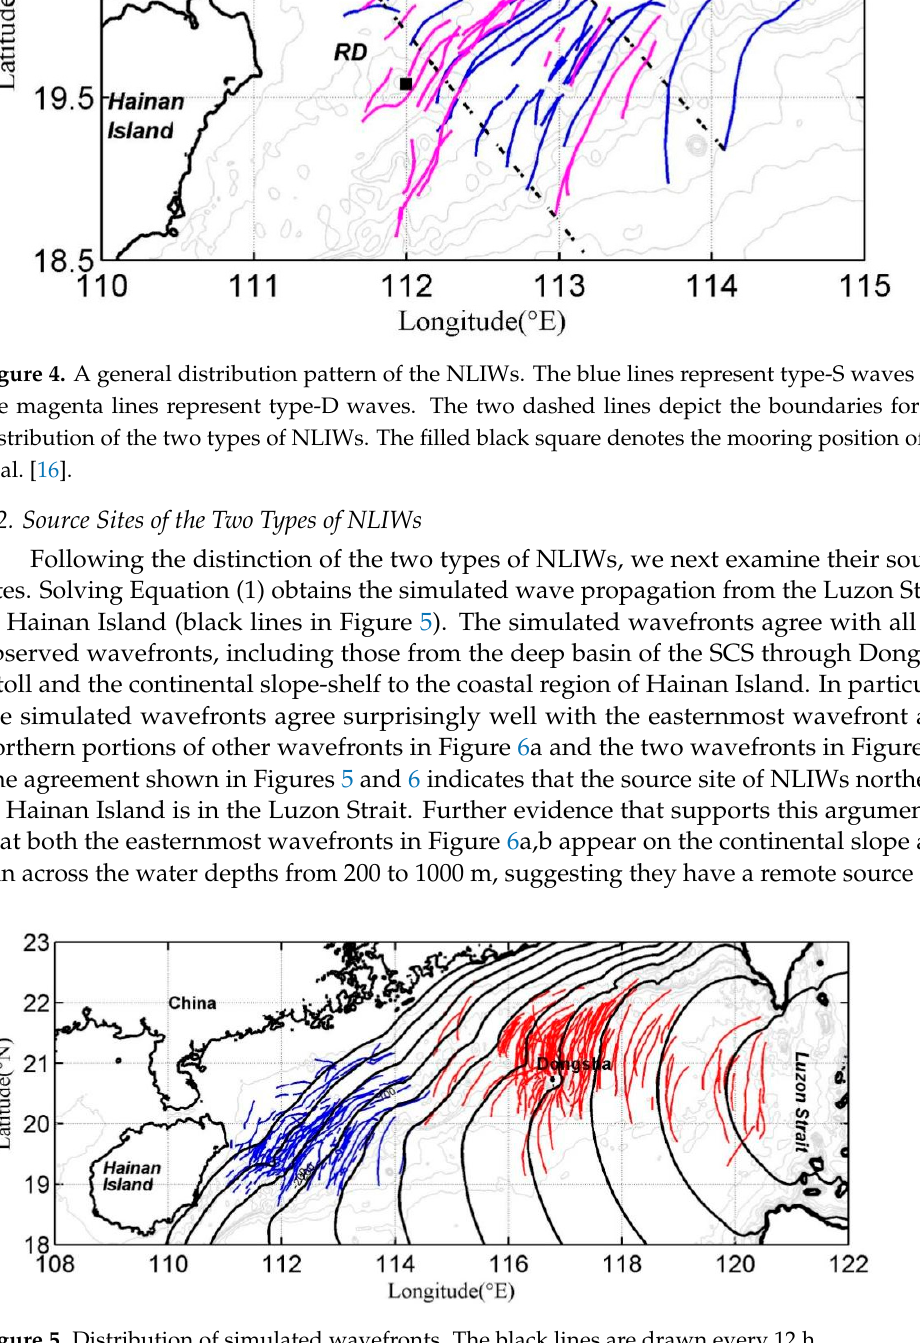
Figure 5. Distribution of simulated wavefronts. The black lines are drawn every 12 h.